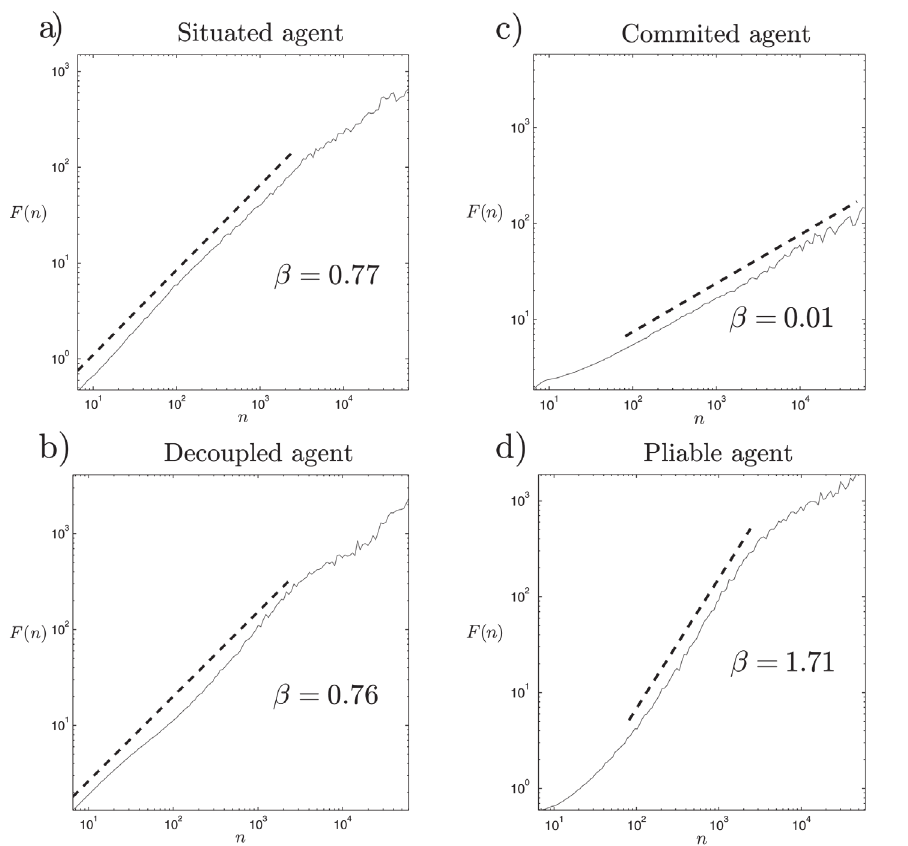
displays either c) white noise for committed agents or d) brown noise for pliable